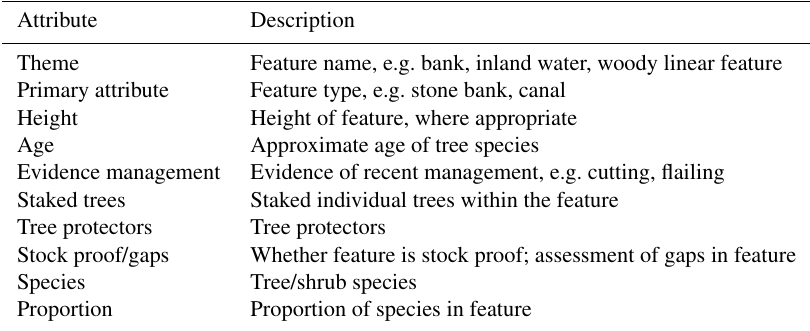
Table 4. Data collected regarding